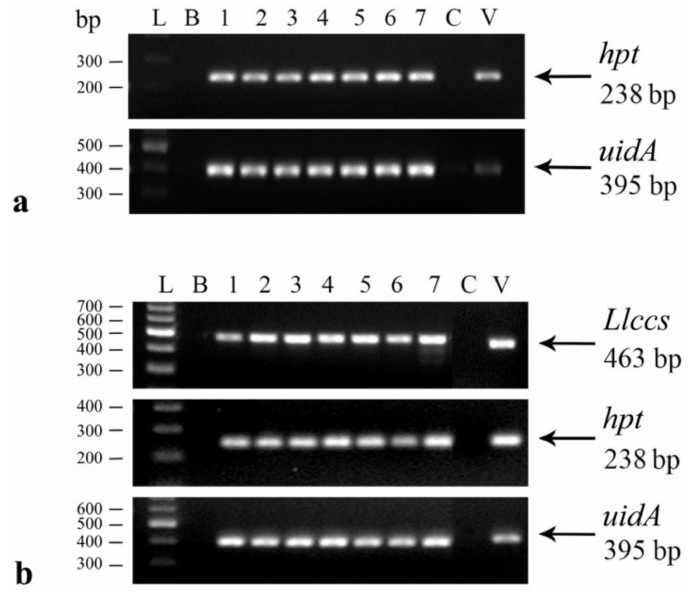
Figure 5. PCR analysis of genomic DNA of selected Llccs − transgenic shoots ( a ) and Llccs + shoots ( b ). hpt —hygromycin phosphotransferase; uidA — β -glucuronidase; Llccs —capsanthin/capsorubin synthase; L—ladder (DNA ladder, 100 bp); B—blank; C—control (untransformed sample); V– vector: ( a ) pWBVec10a or ( b ) pWBVec10a/CaMV 35S:: Llccs ::TNos; 1–7—selected